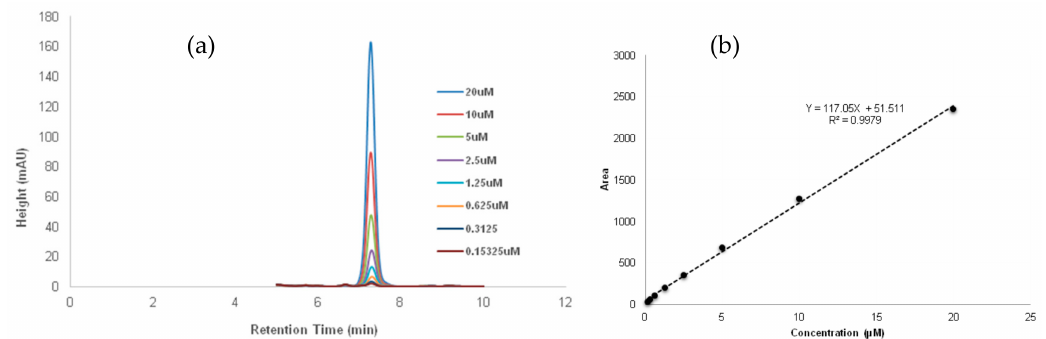
Figure 2. Standard curve of λ -cyhalothrin. ( a ) The chromatogram overlay of the serial dilutions of the insecticide; ( b ) The standard curve plotted between peak areas and the various concentrations of the